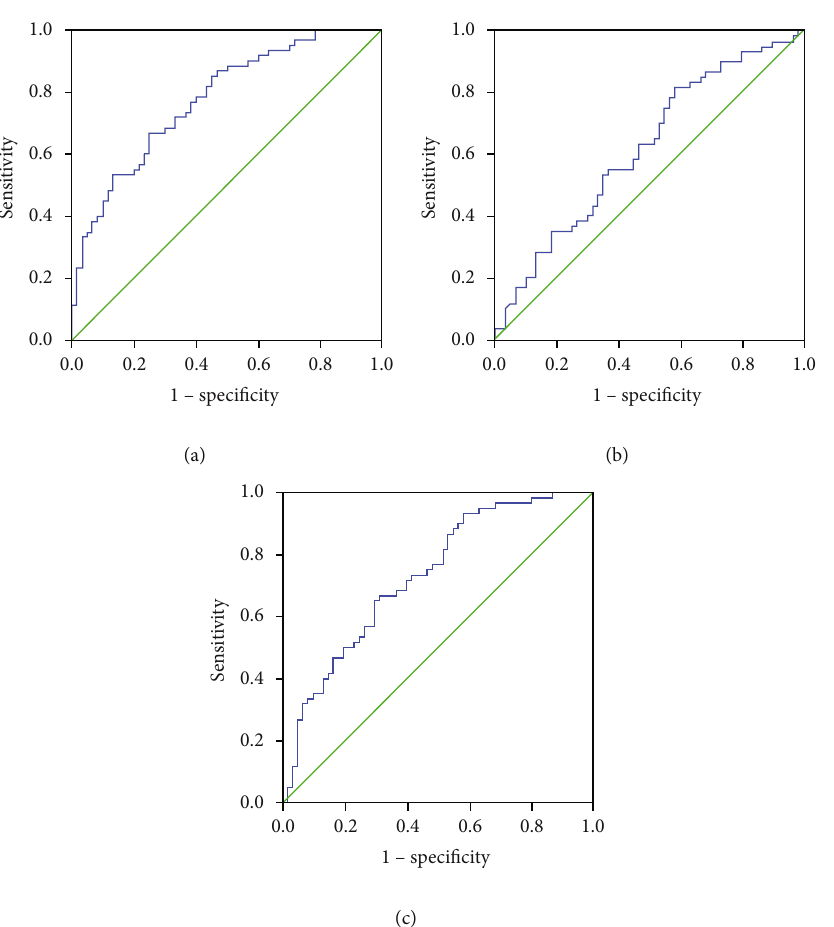
Figure 4: ROC curves of most potential cytokines for postoperative recurrence of CRSwNP. (a) Eotaxin; (b) IL-17; (c) RANTES. ROC: receiver-operating characteristic; CRSwNP: chronic rhinosinusitis with nasal polyps; IL: interleukin; RANTES: regulated upon activation normally T expressed and presumably secreted. Table 5: ROC analysis results of di ff erent cytokines for predicting CRSwNP recurrence.